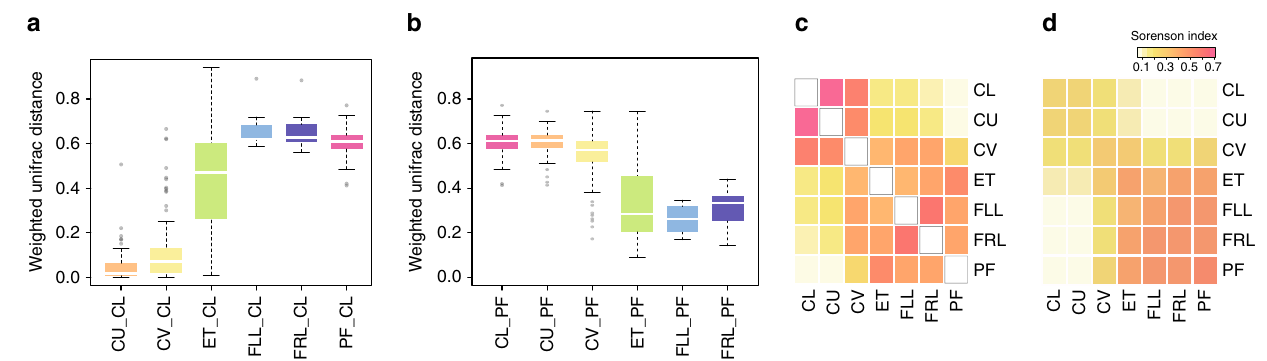
Fig. 3 Similarity of the vagino-uterine microbiota within and between individuals. a , b Weighted UniFrac distance of the microbiota at each body site relative to the CL ( a ) and PF ( b ) in the same individual. Boxes denote the interquartile range (IQR) between the fi rst and third quartiles (25th and 75th percentiles, respectively), and the line inside the boxes denote the median. The whiskers denote the lowest and highest values within 1.5 times the IQR from the fi rst and third quartiles, respectively. Circles represent data points beyond the whiskers. c Intra-individual Sorenson indices between different body sites. d Inter-individual Sorenson indices between different body sites. Samples derive from the study cohort of 95 reproductive-age women ( n = 94 CL, 95 CU, 95 CV, 80 ET, 93 PF, 9 FLL and 10 FRL, Supplementary (Supplementary Fig. 6, sterile saline for the peritoneal samples and PBS for the remaining samples).